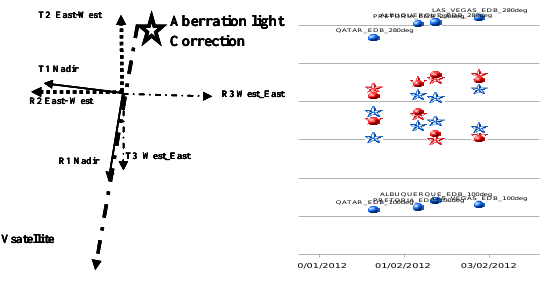
Figure 4. Light aberration correction and various images orientation (instrument yaw) On the right side of Fig.4 is shown the bias in roll (blue) and pitch (red) for some image couples at the same location but with inverse orientation East-West and West-East. The biases without light aberration correction (circle) have a great difference in roll axis about 45µrad in the couple. The biases with light aberration correction (stars) are